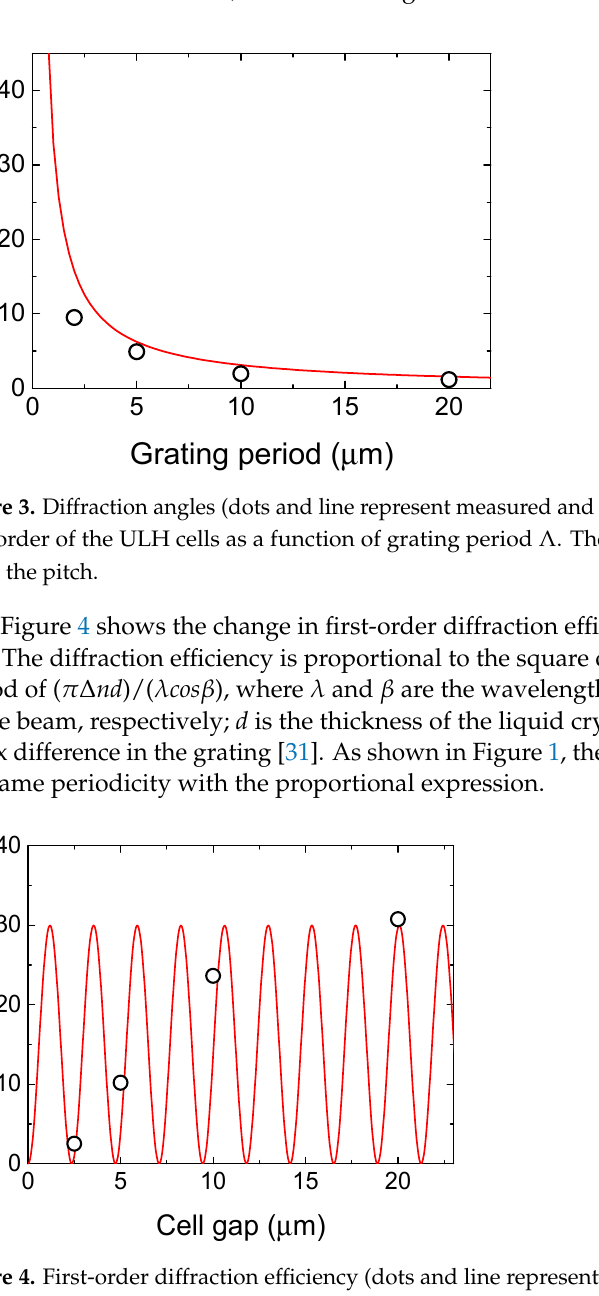
Figure 4. First-order diffraction efficiency (dots and line represent measured and fitted results with the proportional expression, respectively) of the ULH cells as a function of the cell gap. The thickness of LC cells was set as twice the pitch.